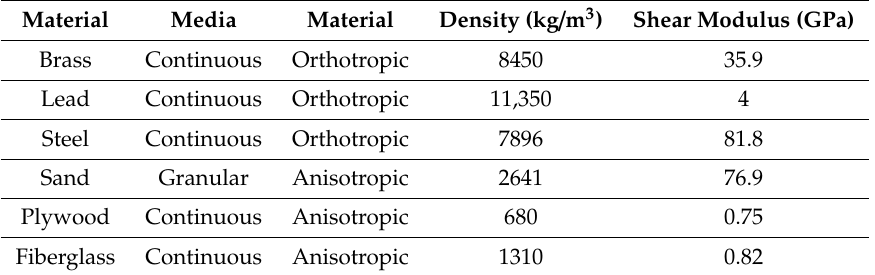
Table 2. Mechanical properties required in the simulation.